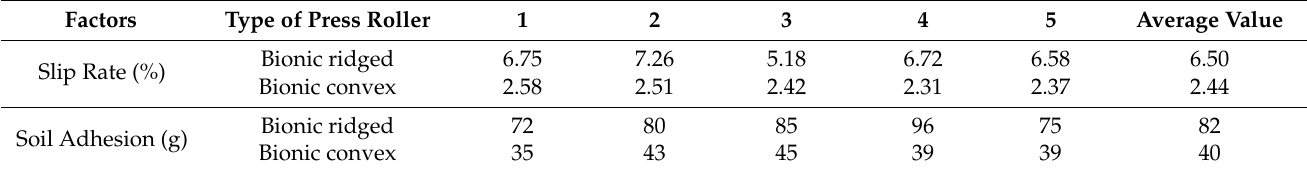
Table 6. Working performance comparison of the bionic convex and bionic ridged press